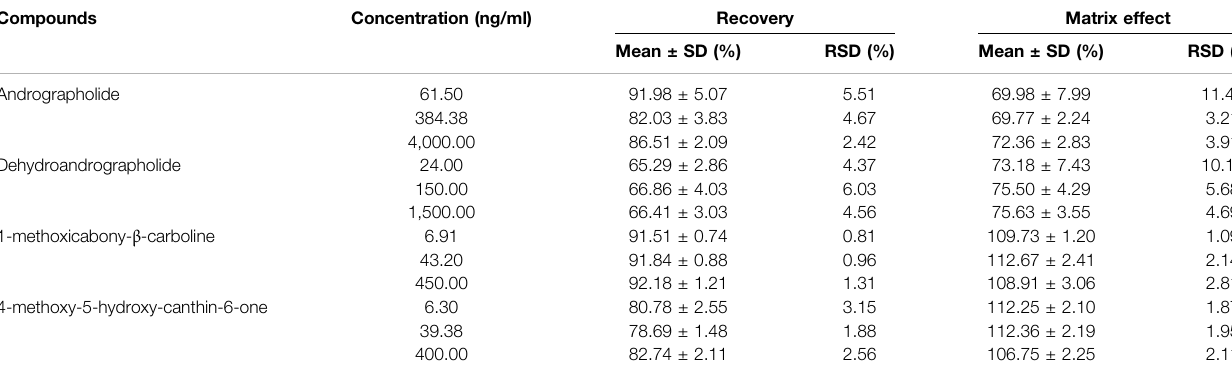
TABLE 4 | Recovery and matrix effects of the four compounds in rat serum ( n = 6).